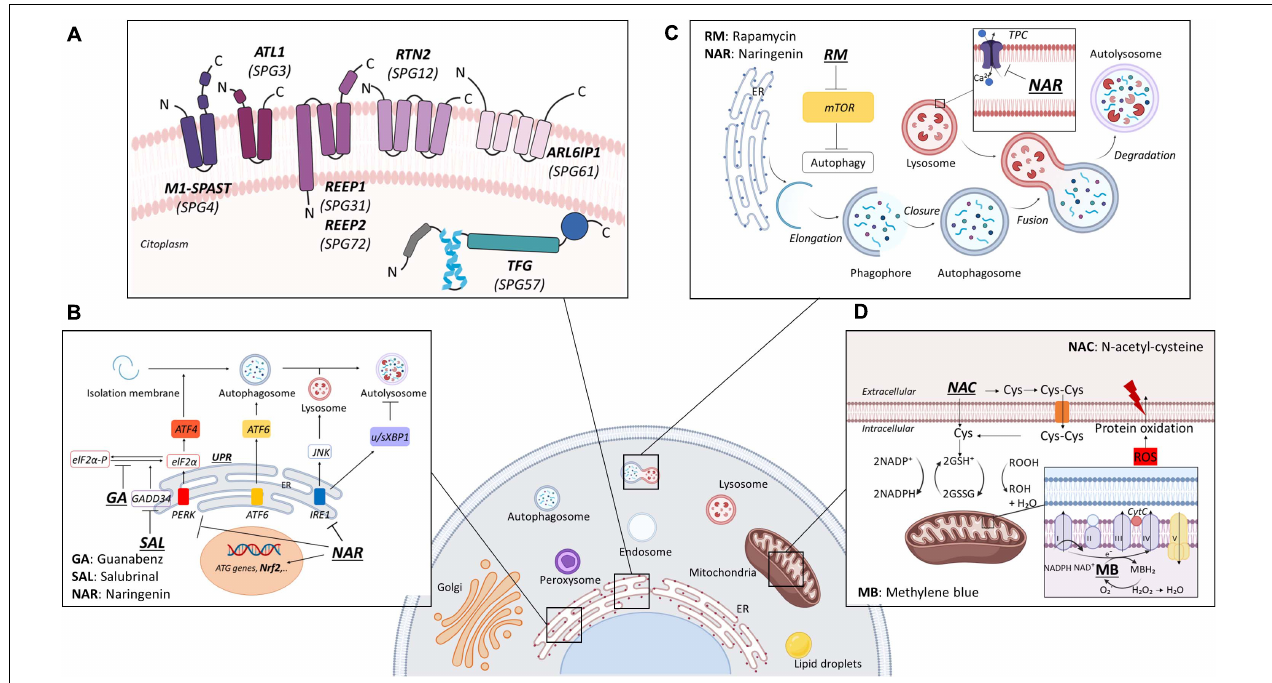
FIGURE 1 | Summarized molecular targets of the small molecules as hereditary spastic paraplegia (HSP) therapeutics. (A) Schematic view of the ER-linked HSP proteins and their localization. (B) Guanabenz, salubrinal, and narigenin are involved in the reduction of ER stress, acting on UPR components or Nrf2, the master regulator of antioxidant responses. (C) Rapamycin specifically binds to mTOR and activates autophagy, whereas NAR inhibits TPC channels on lysosomes. (D) NAC is an aminothiol and synthetic precursor of intracellular cysteine and glutathione (GSH), acting as an antioxidant or free radical scavenger. Abbreviations: ER, endoplasmic reticulum; UPR, unfolded protein response; Nrf2, nuclear factor erythroid 2-related factor 2; PERK, protein kinase R-like ER kinase; ATF6, activating transcription factor 6; IRE1, inositol-requiring enzyme 1; eIF2 α , eukaryotic initiation factor 2 α ; eIF2 α P, phosphorylated eukaryotic initiation factor 2 α ; GADD34, growth arrest and DNA damage-inducible protein; mTOR, mammalian target of rapamycin complex 1; ROOH, organic hydroperoxide; cys, cysteine; Cys-Cys, cysteine; cyt, cytochrome c; ROS, reactive oxygen species; TPC, two-pore channel. Created with